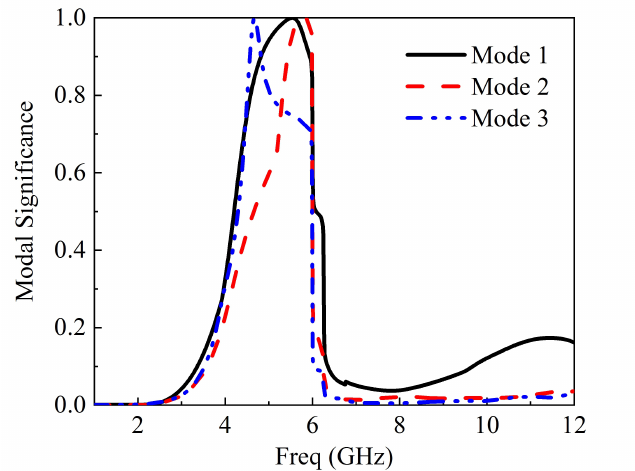
Figure 12. Modal significance at 5.5 GHz.